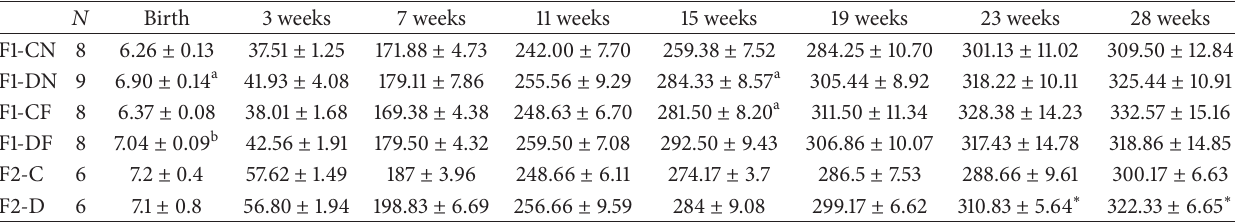
Table 1: Body weight (grams) of F1 and F2 females.